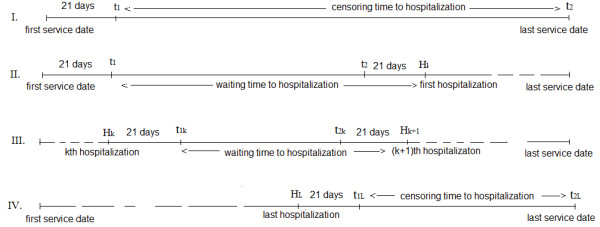
Calculation of waiting time to hospitalization in four situations. I. Patients with no hospitalization with a complete set of observations after t1, where t1 is 21 days after the first service date. II. Patients with hospitalization with a complete set of observations in the first hospitalization interval [ t1,t2], where t1 is 21 days after the first service date and t2 is 21 days before the first hospitalization. III. Patients with hospitalization who had their first complete set of observation in the kthhospitalization interval [ t1k,t2k], where t1kis 21 days after the kthhospitalization and t2kis 21 days before the (k+1)thhospitalization. IV. Patients with hospitalization who had their first complete set of observation in the last hospitalization interval [ t1l,t2l], where t1lis 21 days after the last hospitalization and t2lis the last service date.